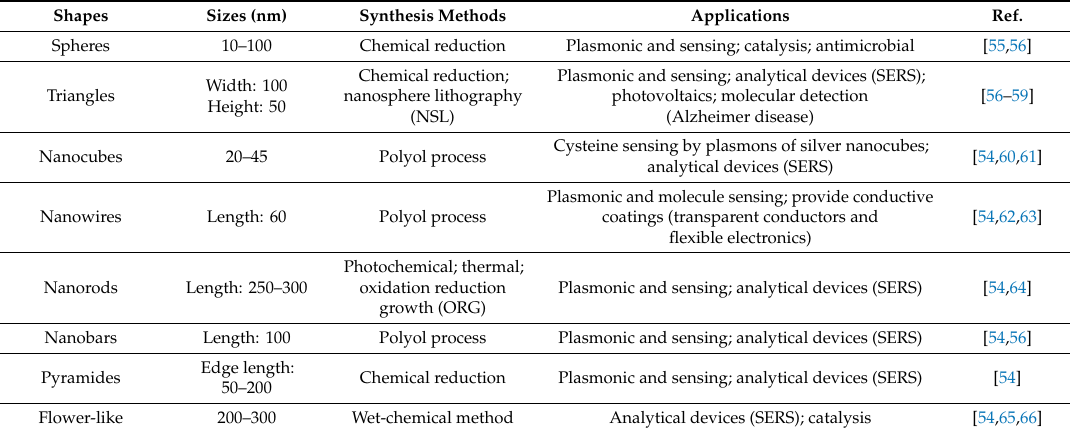
Table 1. Summary of the main strategies employed to synthesize silver nanoparticles (AgNPs) along with the corresponding shape and size, as well as their respective